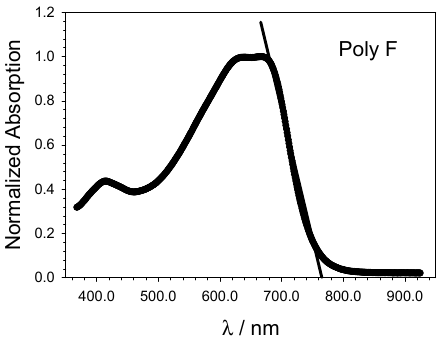
Figure 3. Poly F UV-vis spectrum, the line used to determine the onset wavelength is shown. The intercept with the absissa allows us to determine the optical band gap ( ∆ E OPT